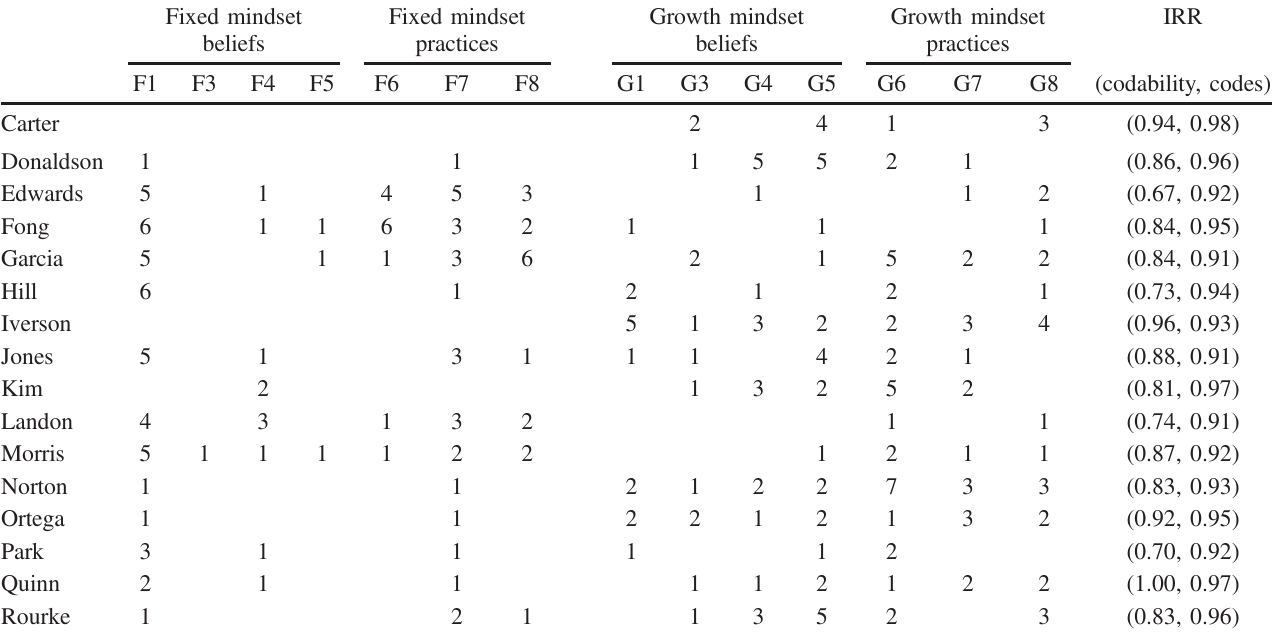
TABLE III. Results of coding interviews with graduate admissions committee members for fixed and growth mindset, documenting the frequency of each code (F1, F2, etc.) for each interviewee (Carter, Donaldson, etc.). Inter-rater reliability is presented for both codability (the extent to which coders agreed that each given paragraph should be associated with one or more of the codes) and codes (the extent to which coders agreed on the specific codes to be associated with that